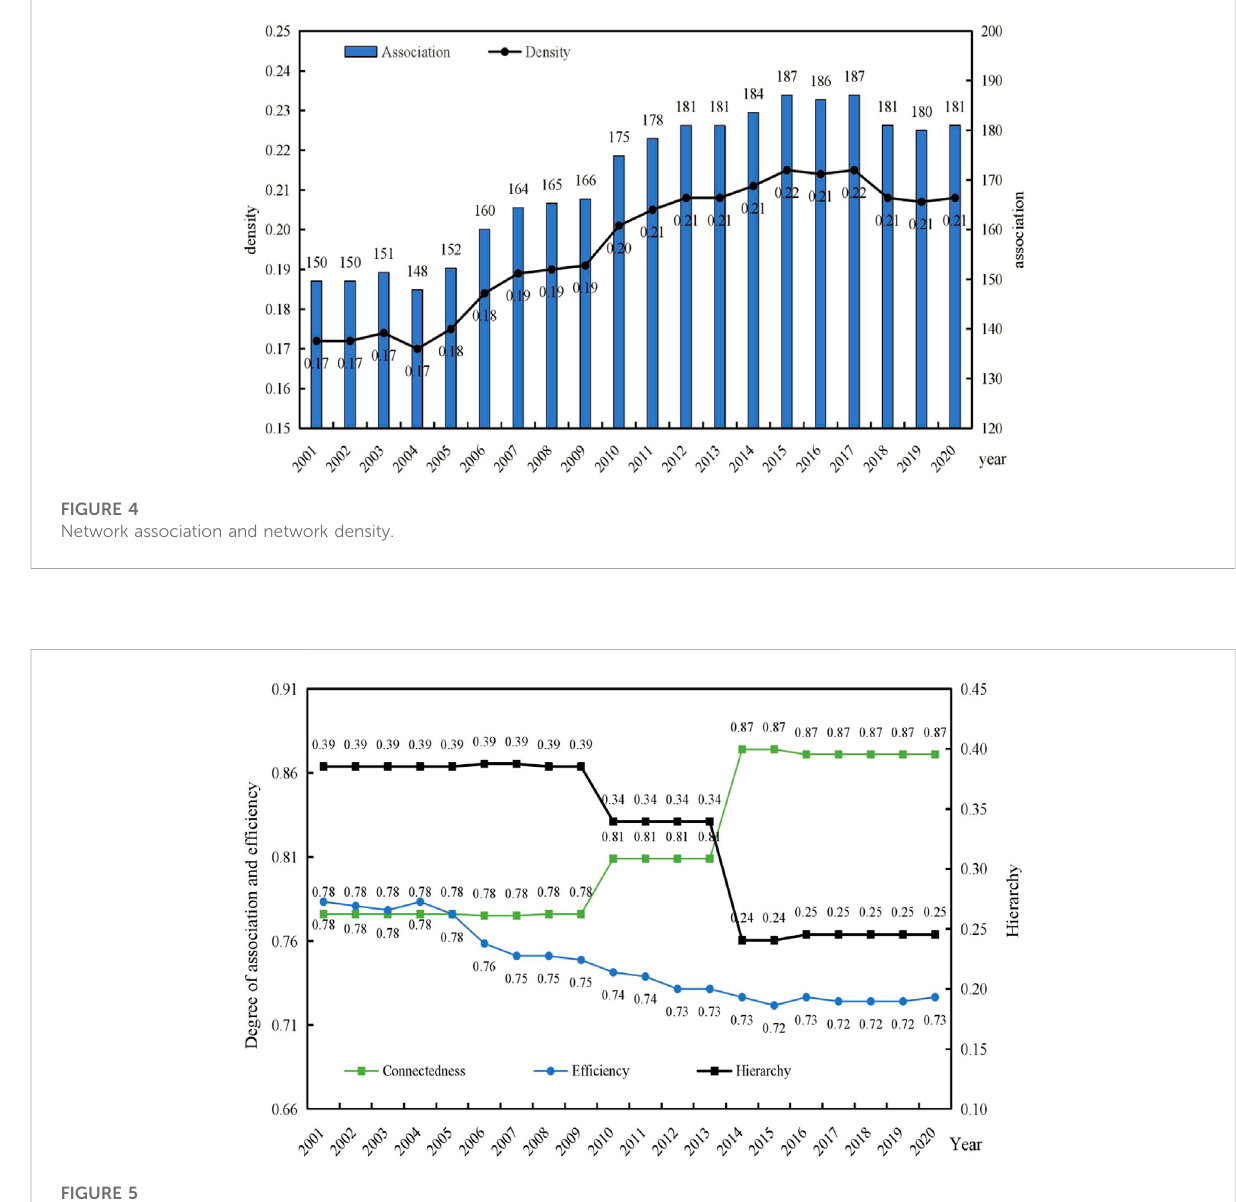
FIGURE 5 Network association, network ef fi ciency, and network